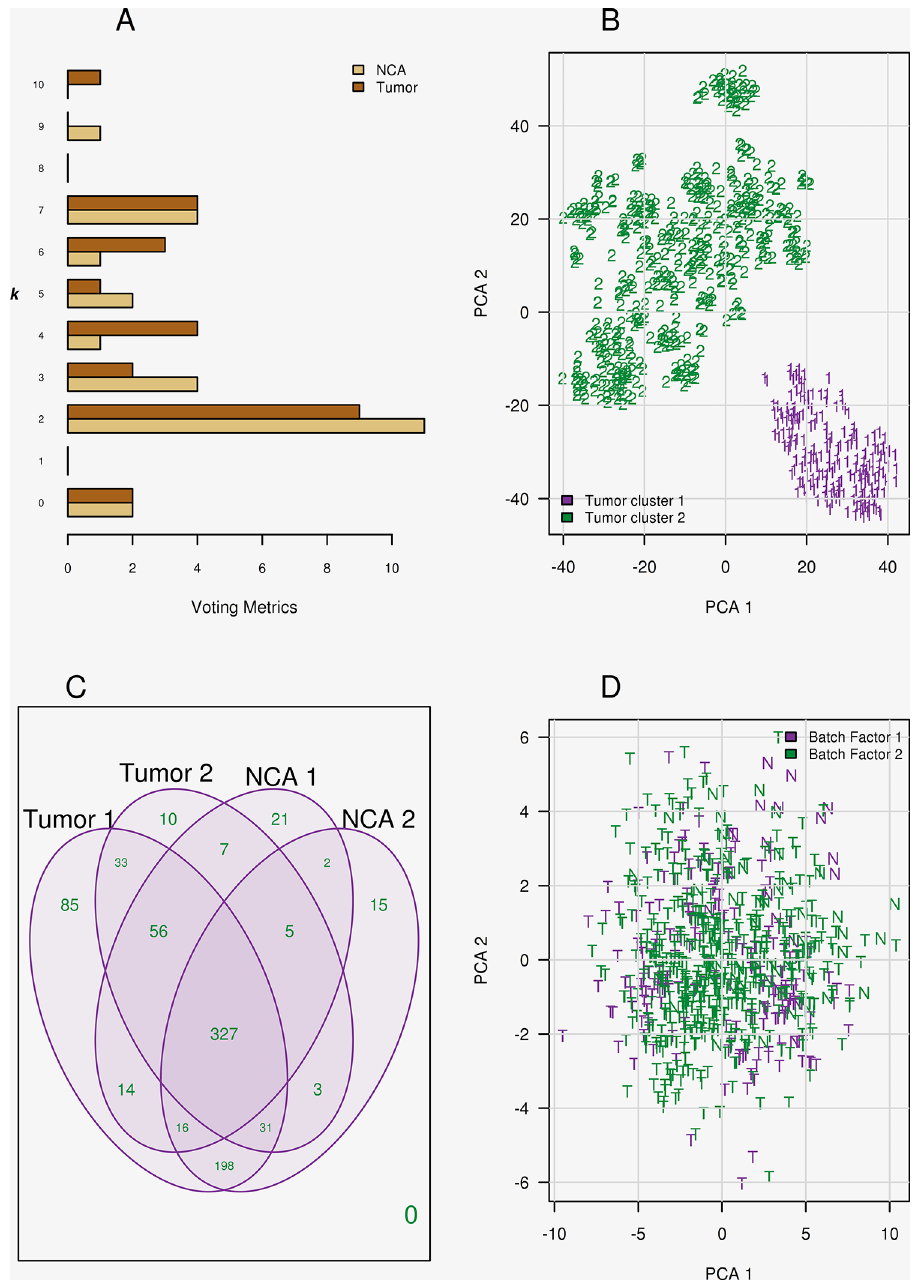
Fig 1. Two distinct microbiota are present in breast tissue samples, both tumor ( n = 668) and NCA ( n = 72). (A) Optimal k -cluster selectionanalysisdemonstrating a majority decisionamongthe 26 metrics for 2 clusters was concordant for both tissue cohorts identifying a systemic handlingbias. (B) The t-SNE projections for the 668 tumors samples, demonstrating tissues demonstrating separation and cohesion amongthe batches. (C) Filtering was re-appliedamongthe tissue samples and per processingdifferences. Venn diagramdemonstrates a core 327 bacterialOTU’s was observed amongall samples. (D) Abundance differences were observed for 48 OTU’s. A PCA plot of these significantOTU’s is presenteddemonstrating that the batch differences had beenaccountedfor, NCA tissues indicatedwith an ‘N’ and tumor samples indicatedwith a